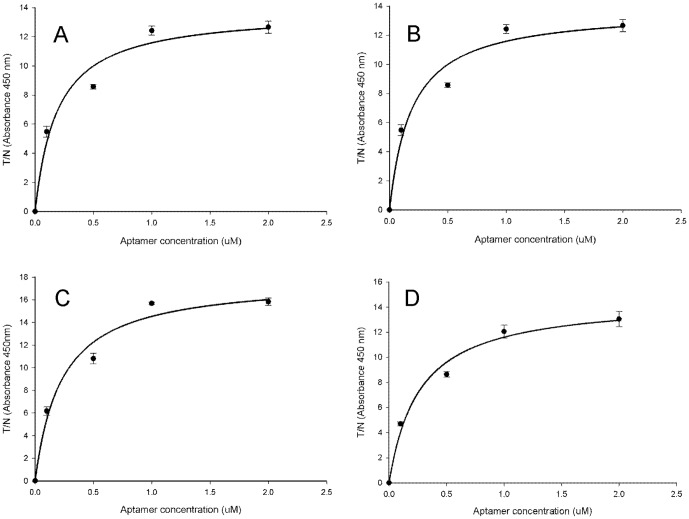
Equilibrium dissociation curves for select aptamers.GII.2. SMV VLPs (3 µg/ml) were screened with different concentrations (10 nM, 100 nM, 500 nM, 1 µM, 2 µM) of each aptamer using ELASA. To estimate Kd, plots of the T/N ratios (absorbance at 450 nm) as a function of the aptamer concentration were fitted to a non-interacting binding sites model with the equation Y = Bmax X/Kd+X. The negative controls consisted of PBS. Results correspond to aptamers SMV 19 (A), SMV 21 (B), SMV 25 (C) and SMV 26 (D).